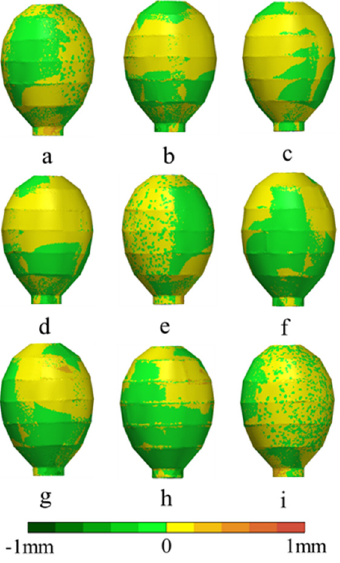
Figure 19. Cloud maps of contour deviation of hulls a–i calculated by MPCR-Net.